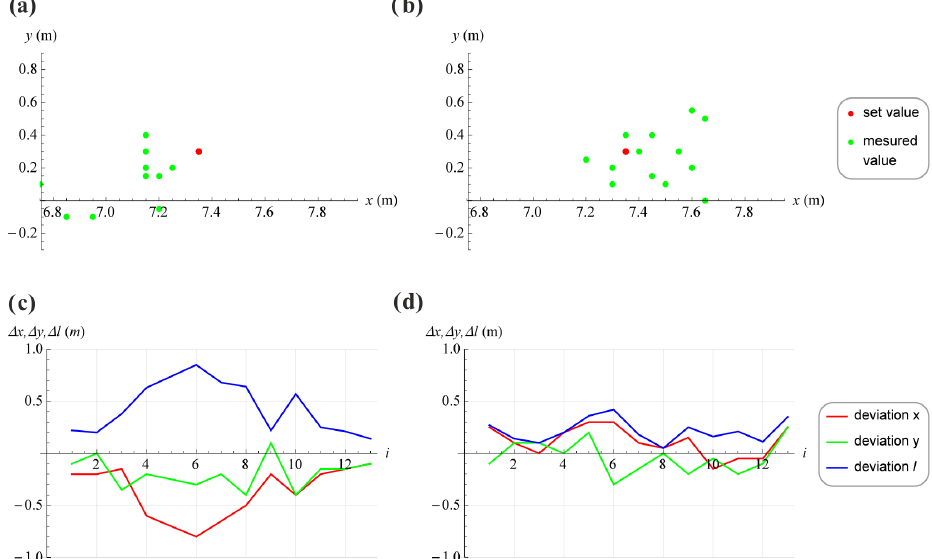
Figure 12. Accuracy measurement of point 5. ( a ) Green points represent measured positions when the robot stops. The red point is an aim point. In this experiment, the robot had the vision system turned off. ( b ) The robot had the vision system turned on. ( c ) Deviations from the aim point in x and y , where the vision system was off. ( d ) Deviations from the point where cameras the vision system was